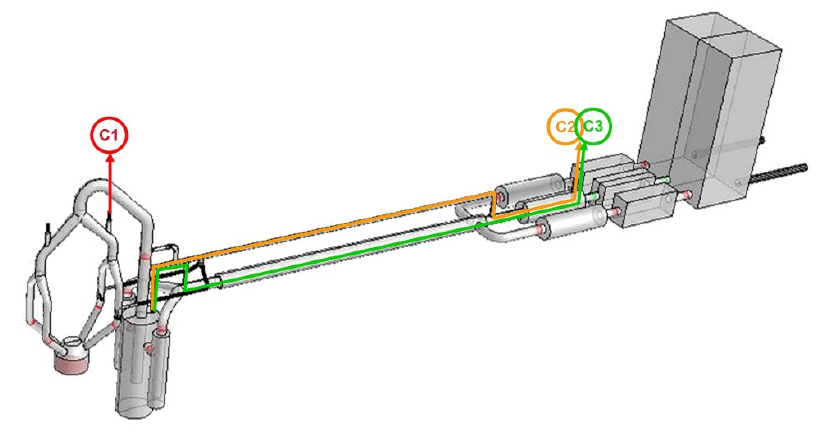
Figure 7. Scheme of the three compared circuits of BF gas. C1, C2 and C3 are the first, the second and the third analyzed circuit, respectively.